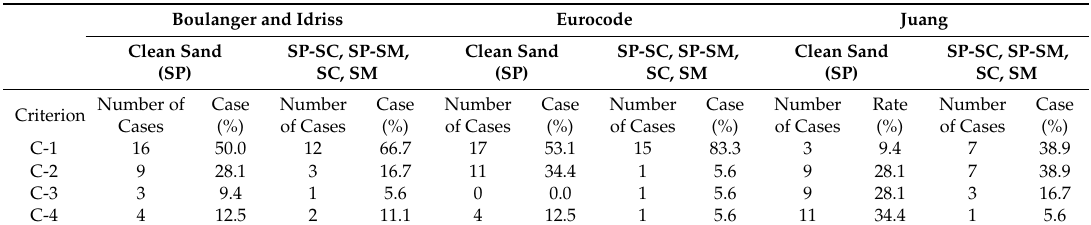
Table 3. Comparative estimation of factor of safety improvements for CPT-based liquefaction triggering assessment according to Boulanger and Idriss, Eurocode, and Juang methods and specifications, after jet grouting using micropiles.